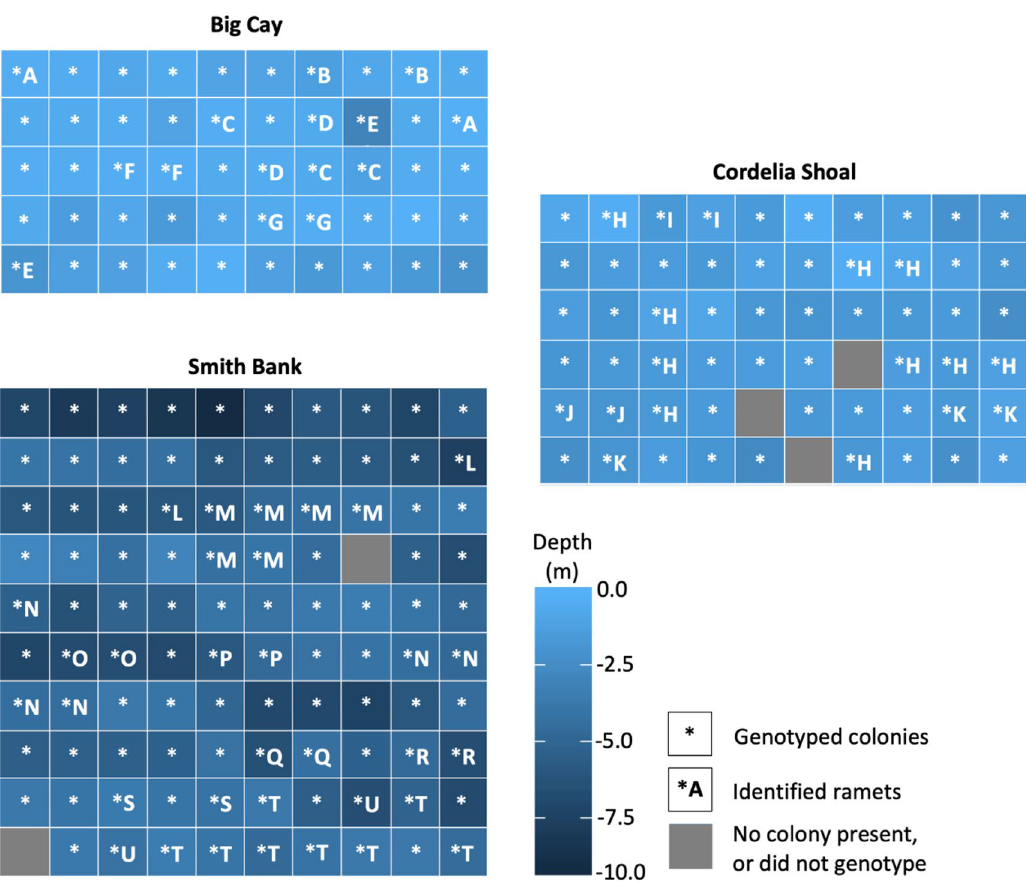
Figure 2. Depth profiles of sampled Acropora cervicornis colonies and location of clones within the three banks of Cordelia Bank Site of Special Importance to Wildlife, each letter represents a unique ramet (clonal